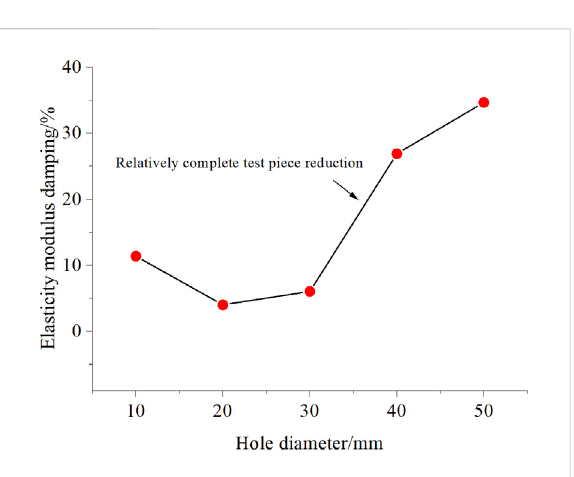
Relationship between the hole diameter and elasticity modulus